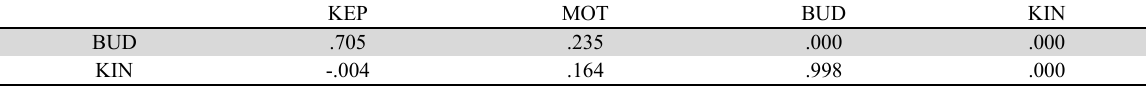
Standardized Direct Effects (Group number 1 - Default model), Work Motivation (MOT), Leadership (KEP), Cultural Organization (BUD) and Performance (KIN)